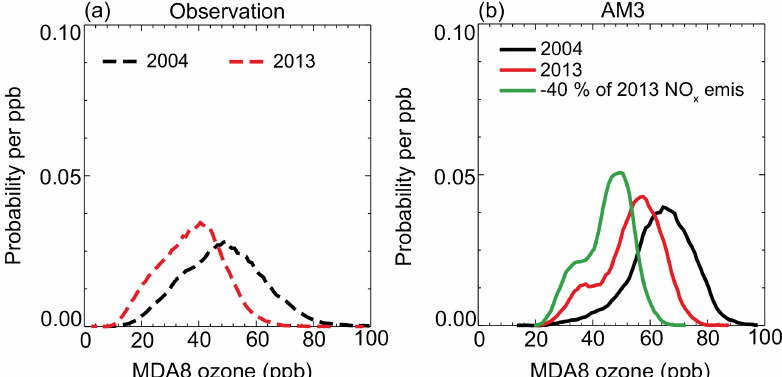
Figure 7. Observed (a) and simulated (b) probability density function of MDA8 ozone at AQS monitoring sites in Fig. S2 in the Supplement during the summers of 2004 and 2013 and a scenario with a 40% reduction in the anthropogenic NO x emissions of